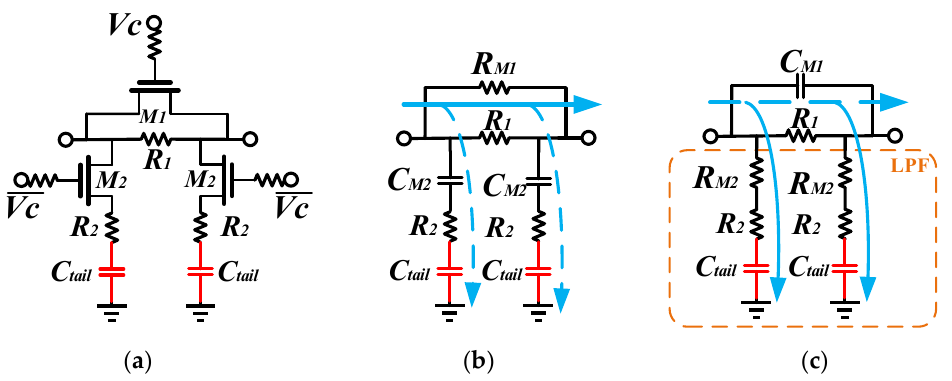
Figure 7. ( a ) The schematic of the switched π -type attenuation cell with tail capacitors. ( b ) Reference state. ( c ) Attenuation state.